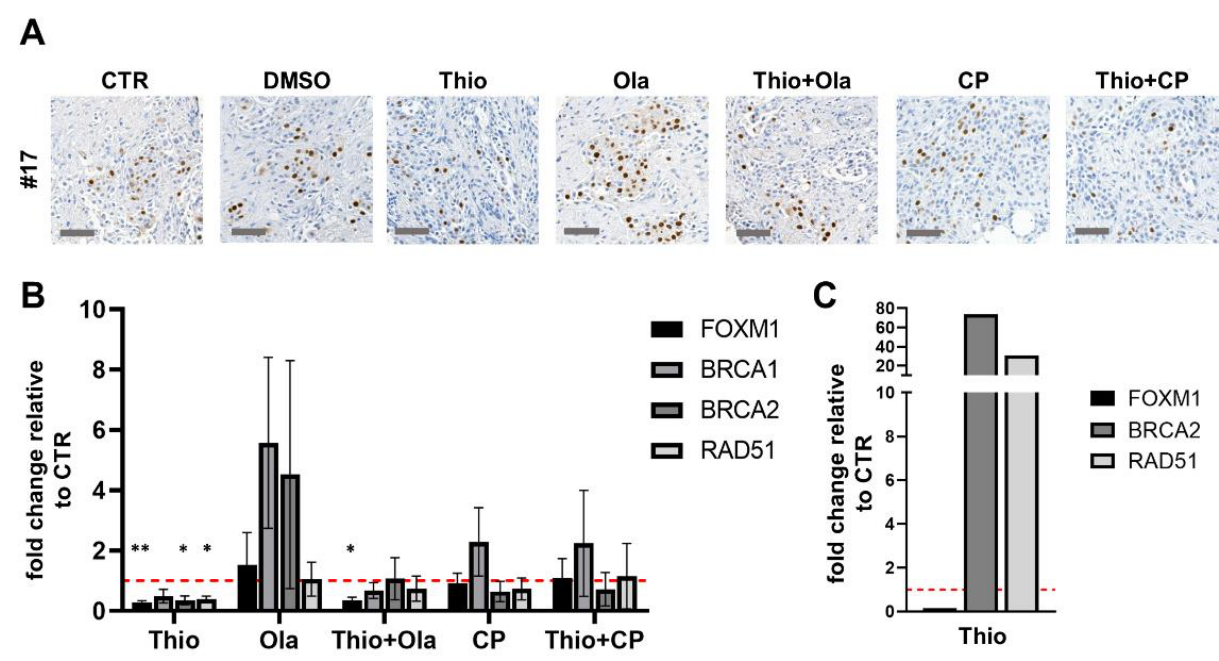
Figure 4. Regulation of the transcription factor FOXM1 and its downstream targets by application of thiostrepton (Thio), olaparib (Ola), and carboplatin (CP). ( A ) Tissue cultures were stained with FOXM1-antibody, representative pictures are shown. ( B ) Thiostrepton successfully downregulated all investigated gene expressions (FOXM1, BRCA1/2, RAD51). Olaparib, however, upregulated FOXM1 and all downstream targets while the addition of thiostrepton encountered this reaction. Carboplatin treatment only showed increased BRCA1 and thiostrepton could not overcome this effect in overall analysis. n = 3, error bars represent SEM, vehicle CTR was set to 1. ( C ) #20 expressed counter-regulation by BRCA2 and RAD51 investigating the FOXM1 inhibitor thiostrepton while FOXM1 was effectively downregulated. Vehicle CTR was set to 1. * p < 0.05, ** p < 0.005 (student’s t -test). Significance was not tested for n =